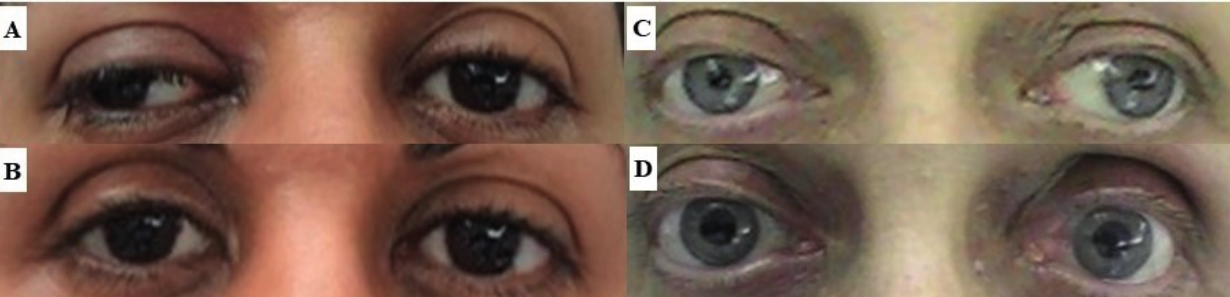
Figure 5. Clinical evaluation. A. Patient 1 pre operative: extropia of the right eye caused by a total rupture of the right MRM; B. Patient 1 post operative: correction of the right eye extropia after MRM reconstruction; C. Patient 2 pre operative: extropia of the left eye caused by a total rupture of the left MRM; D. Patient 2 post operative: correction of the left eye extropia after MRM